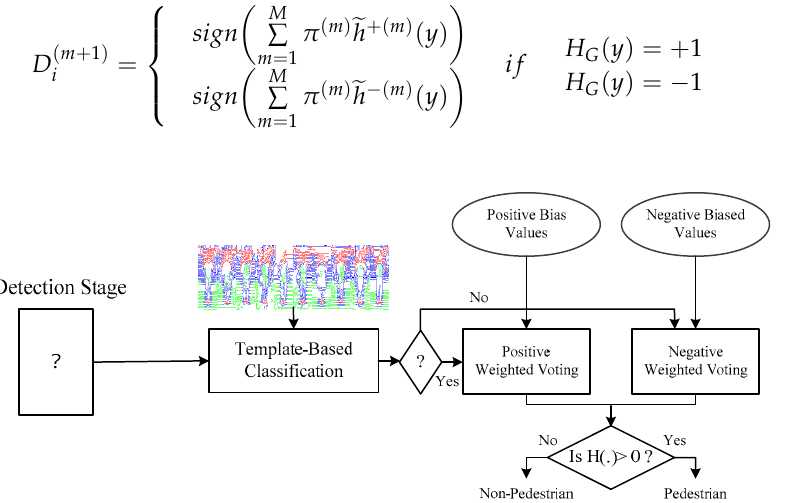
Figure 5. Detection stage: the process to detect the human using the learned detector from biased boosting.